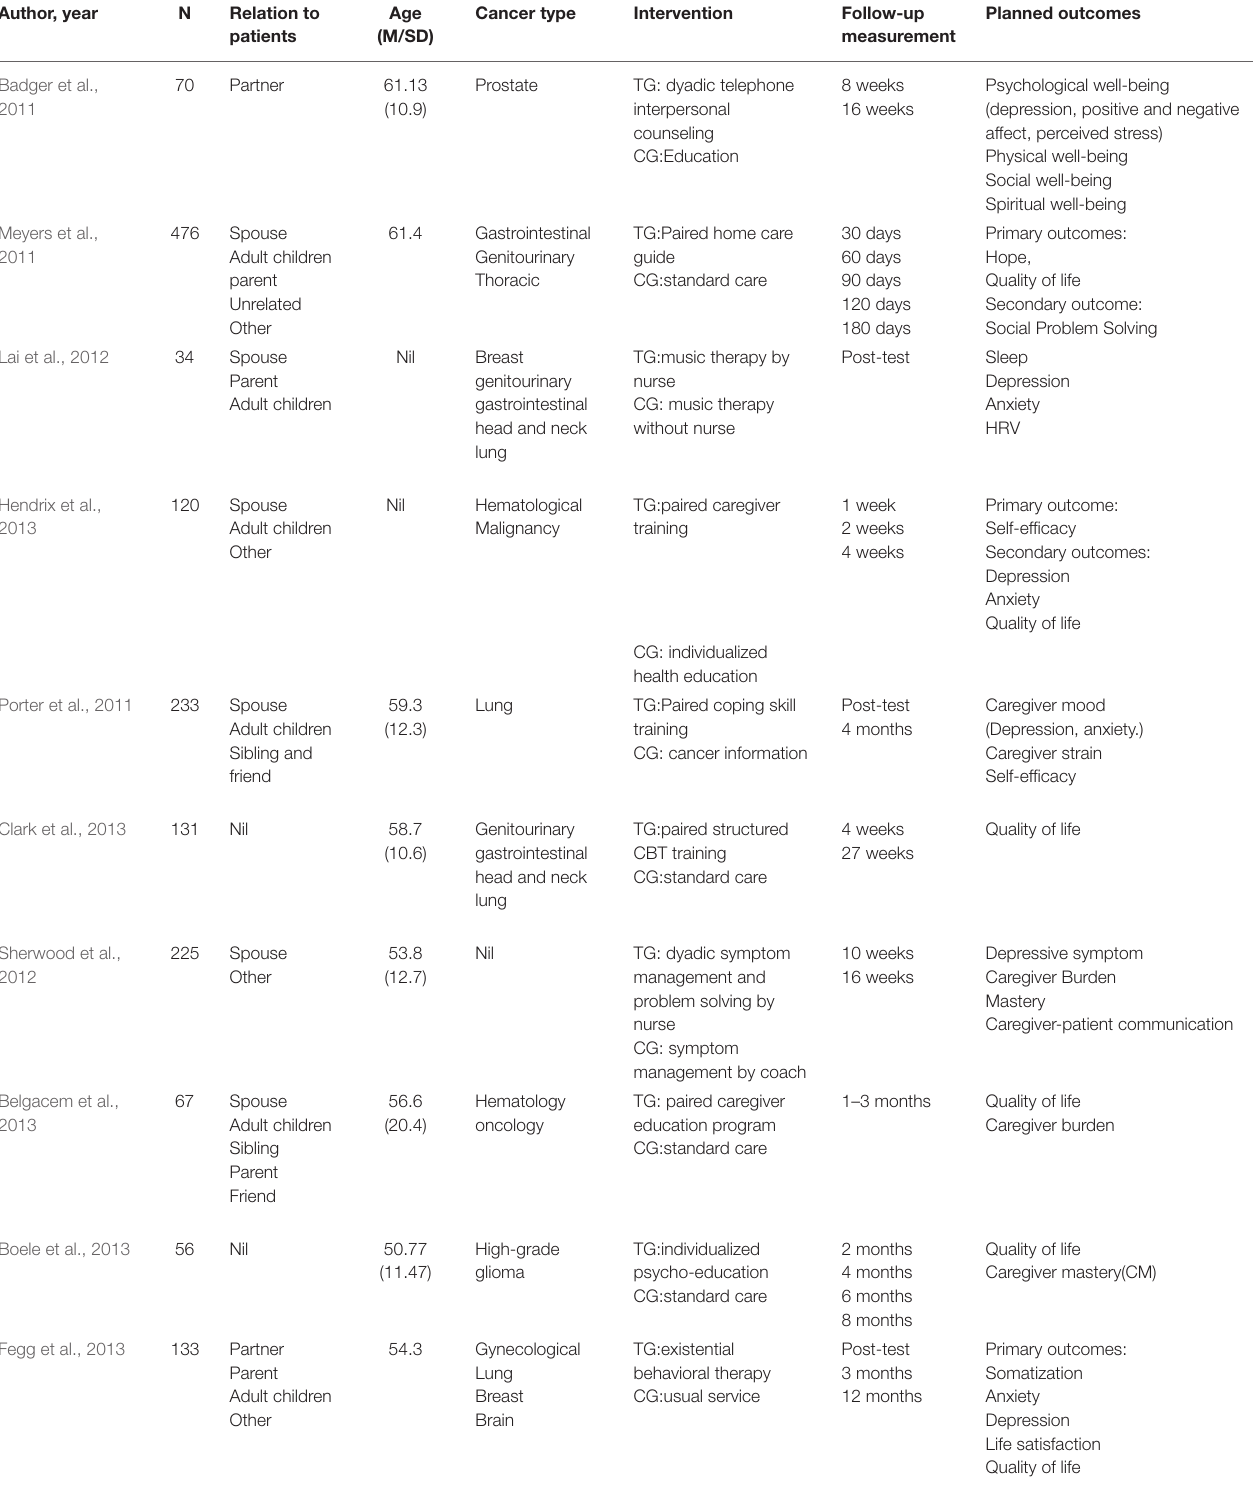
TABLE 1 | Psychosocial intervention of cancer